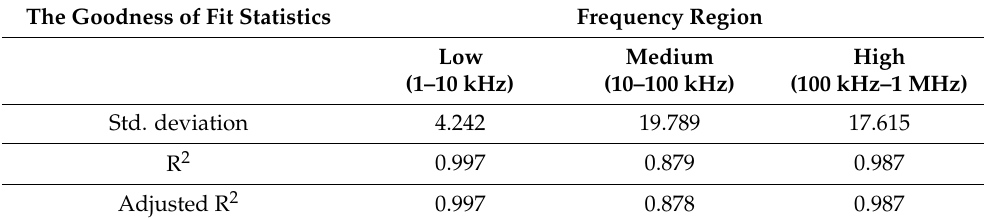
Figure 12. Regression for fingerprint vs. after deformation (high-frequency region). Table 6. Regression analysis for fingerprint vs. after